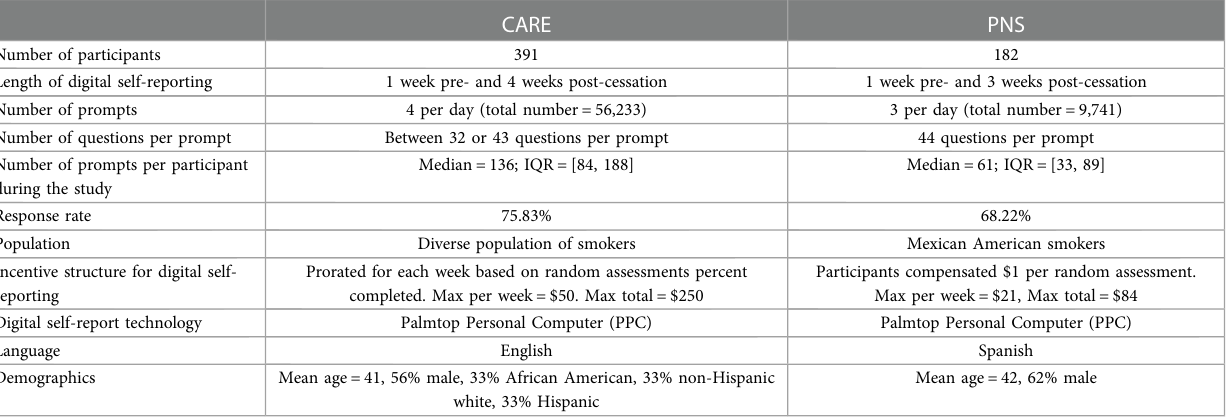
TABLE 1 Comparison of CARE and PNS